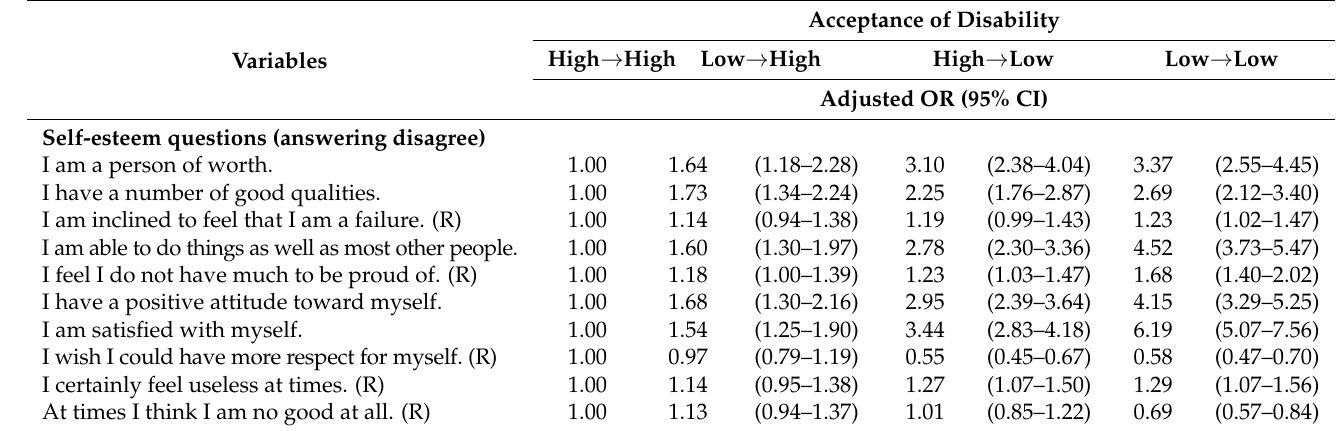
Table 5. Contents of dependent variable analysis concerning self-esteem scale factors according to acceptance of disability a,b,c